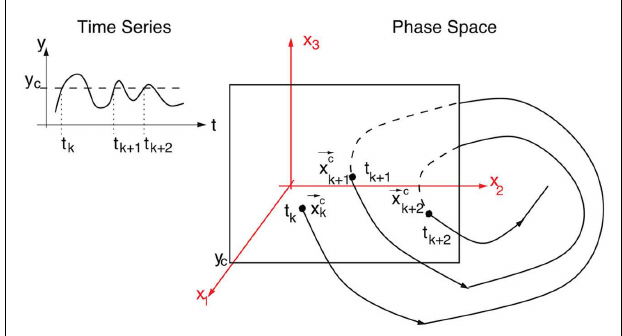
FIGURE 5 | Example of a Poincaré section defined by successive intersections of the trajectories in phase space with the plane denoted as y = y c . The trajectory in phase space intersects the Poincaré section in ( t ) , which then can be used as a map of the space coordinates (cid:3) x c k k underlying dynamical process. Alternatively, a map can be defined by the sequence of crossing times { t k } k = 1,N if the conditions mentioned in the text are